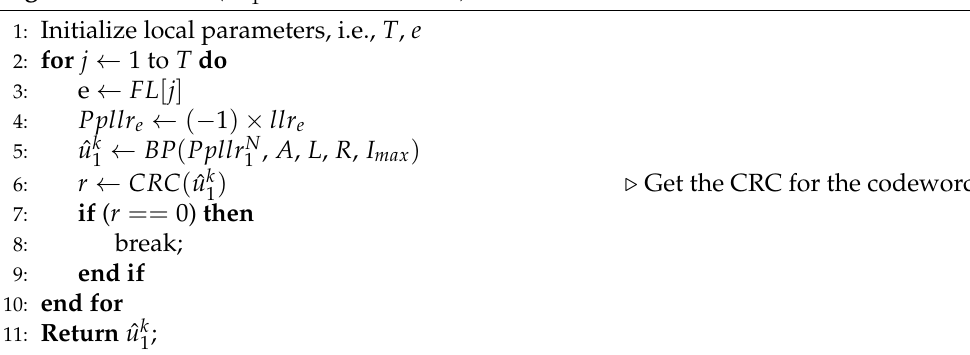
Algorithm 2 FL-BP ( llr N